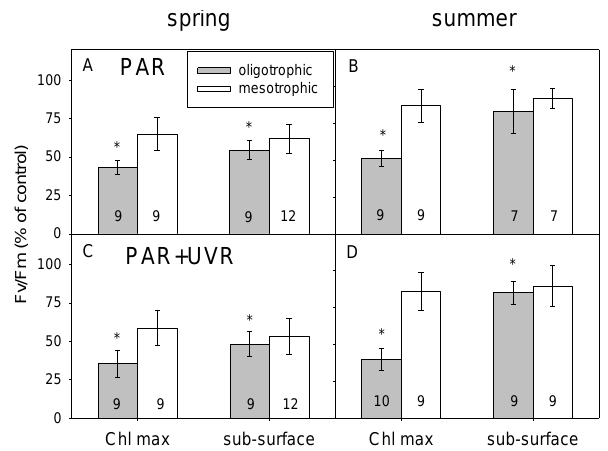
Fig. 5. Latitudinal changes in biomass (chlorophyll a ) for the spring (A, C, E) and summer (B, D, F) cruise. (A, B) Surface Chl a (samples from 10 – 20 m) determined by HPLC. (C, D) Depth integrated Chl a (Chl a t ) as determined from HPLC calibrated CTD fluorescence profiles from the surface to 200 – 410 m. (E, F) Percentage of Chl a in the euphotic zone (0.1% light depth). Black symbols represent data from non-stratified stations.